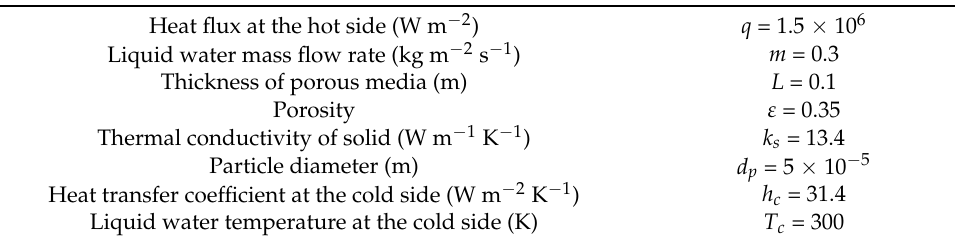
Table 3. Reference value of parameters used in simulations.